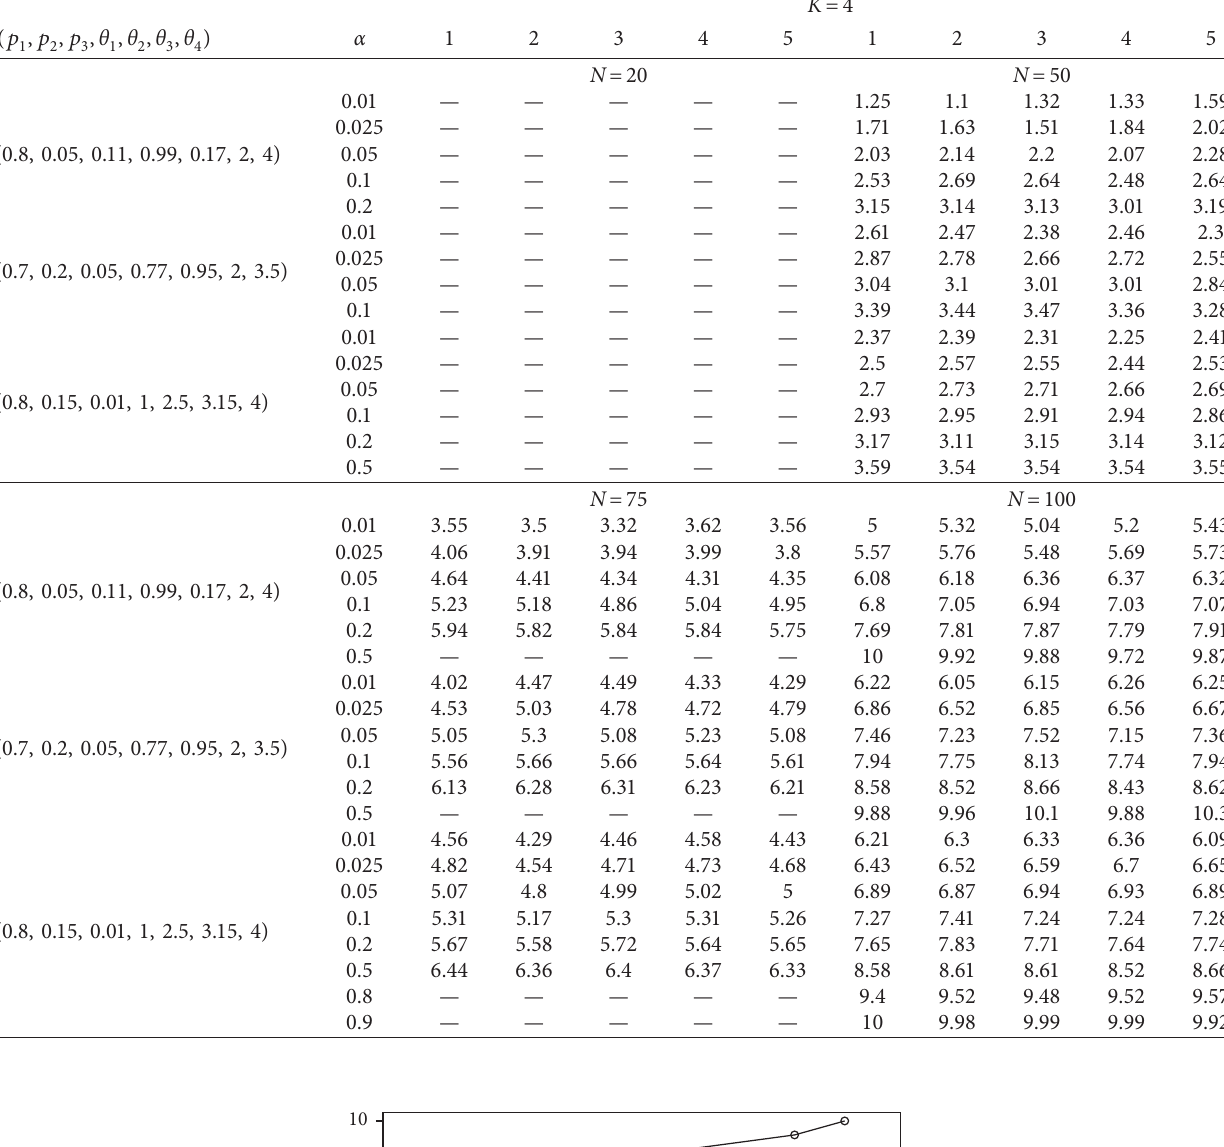
Table 3: Quantiles for estimated number of finite exponential components at k � 4.